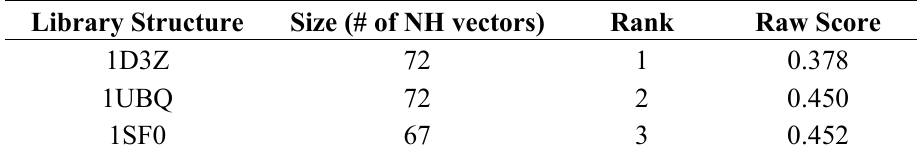
Table 4. Results of structure identification from unassigned experimental RDC data for the protein PDBID:1D3Z.